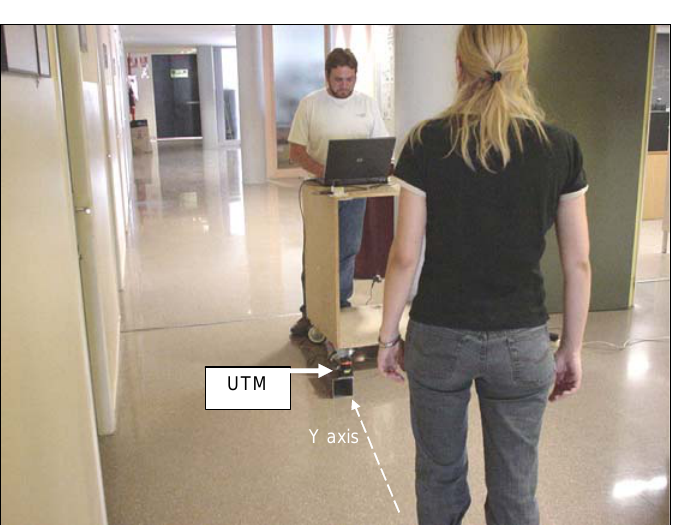
Figure 4. Example of the set of a typical gait